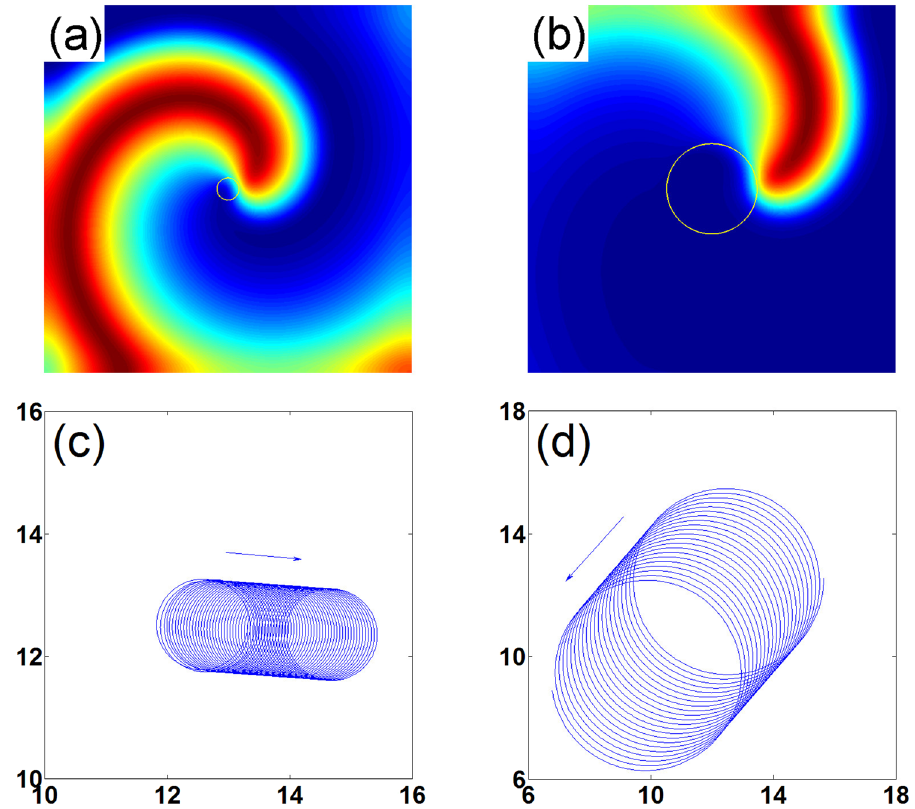
Figure 1. Top row: Tip trajectories of clockwise rotating spiral waves without electric field. Bottom row: Tip trajectories in the presence of a dc electric field. Left column: Highly excitable medium. Right column: Weakly excitable